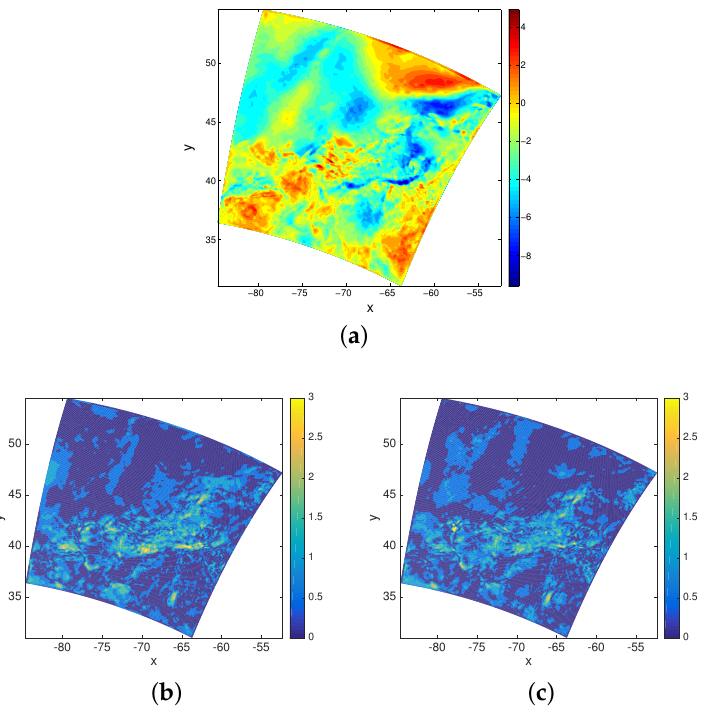
Figure 5. Comparison of the reconstructed field of the first snapshot with different sizes of exclusion disks. ( a ) exact; ( b ) R = 0, absolute errors; ( c ) R = 2, absolute